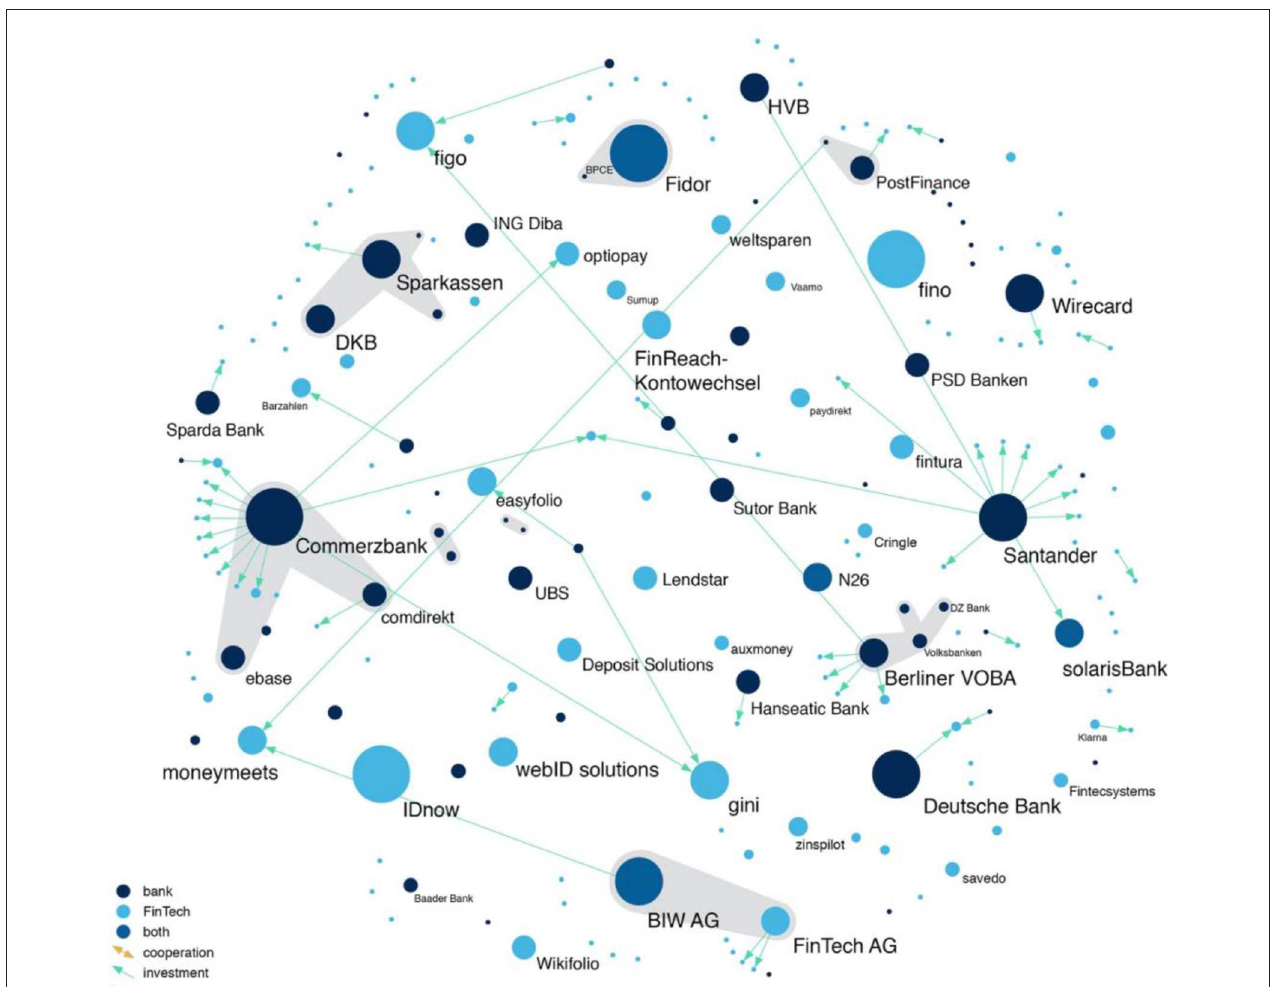
FIGURE 4 | Bank and FinTech